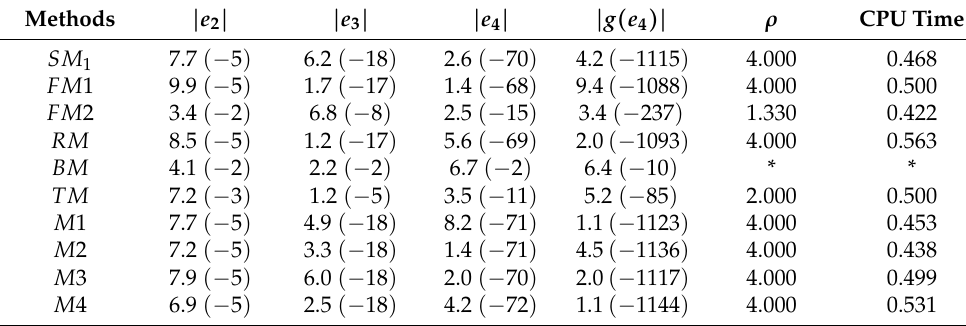
Table 3. The outcomes of Example 3 based on various methods.